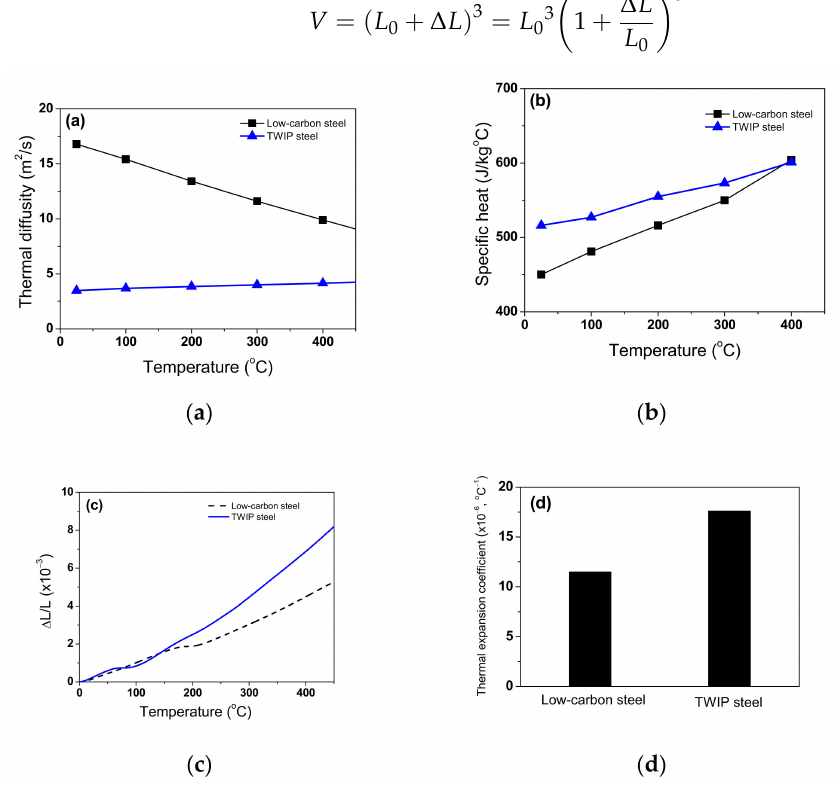
Figure 3. Variations in measured ( a ) thermal diffusivity, ( b ) specific heat capacity, and ( c ) expansion ratio of length as a function of temperature. ( d ) Calculated average thermal expansion coefficient of two steels based on expansion ratio of